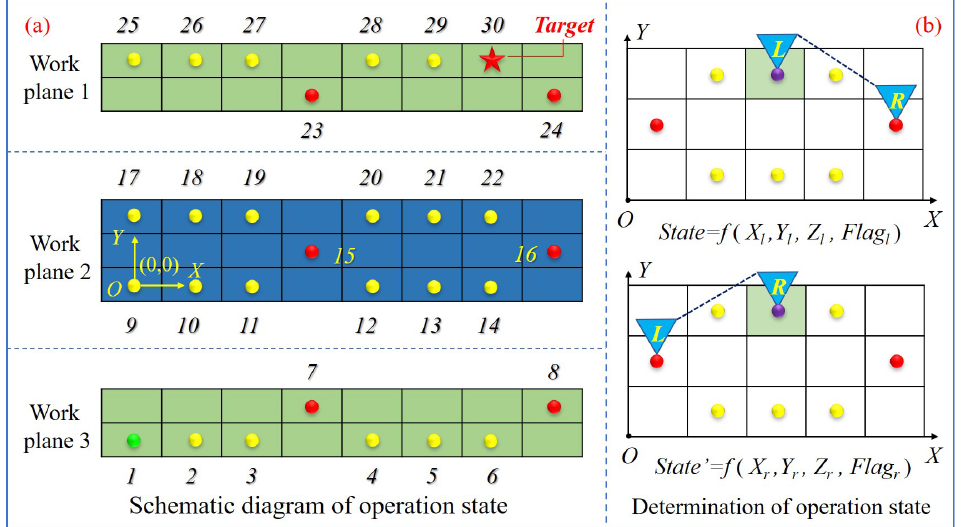
Figure 3. Determination of the AstroLimbs state. ( a ) Schematic diagram of operation state. ( b ) Deter- mination of operation